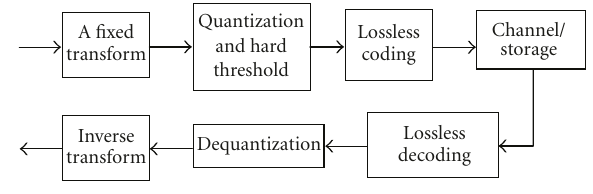
Figure 4: Generic transform-based image compression/decom- pression